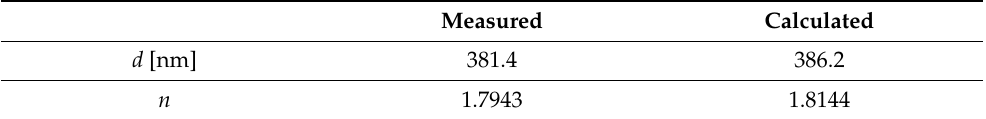
Table 3. Comparison of the refractive index and thickness values for the waveguide Wg2 which were measured and theoretically predicted from the characteristics d ( v ) and n ( v ).